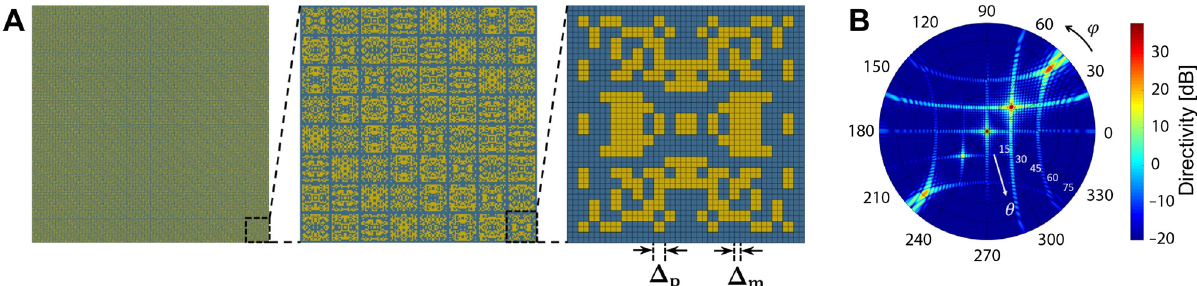
Figure 5: Free-form optimization of plasmonic reflective beam deflector. ( A ) Materialdistributionimageoftheproposedmetasurface,whichis composedof 10 × 10periodicidenticalsuper-cells, designedto re fl ect a normally incident beam to the target direction. (Left) Magni fi ed view of 8 × 8 super-cells of the metasurface (middle) and the lower-right unit- cell of the super-cell (right). ( B ) Polar re fl ection pattern of the designed metasurface shown in a form of directivity. A , B adapted with permission from [71]. Licensed under CC BY